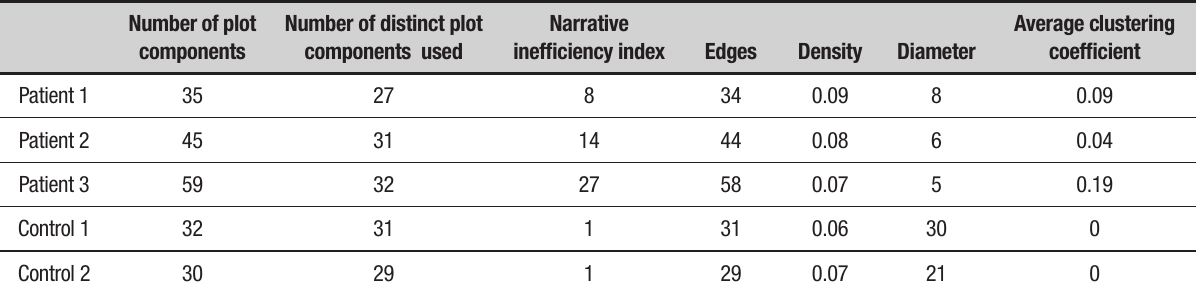
Table 1. SGA Parameters of graphs for ADHD subjects and